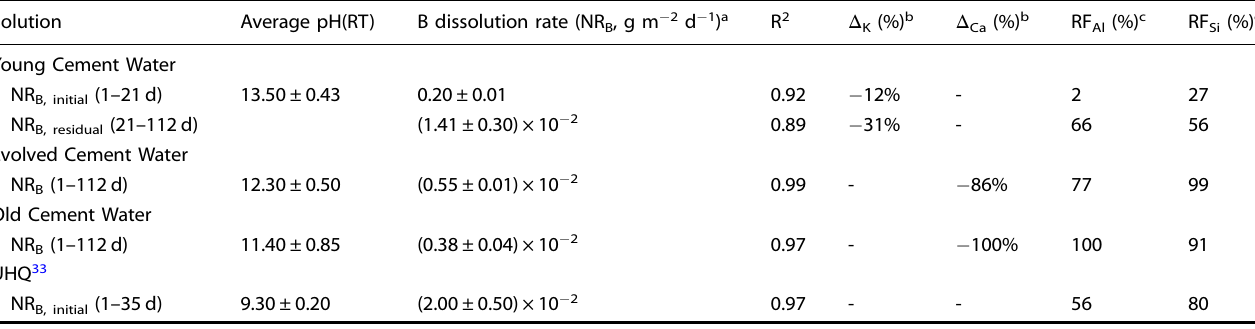
Table 1. Measured solution parameters for CaZn28 glass dissolved in synthetic cement solutions.